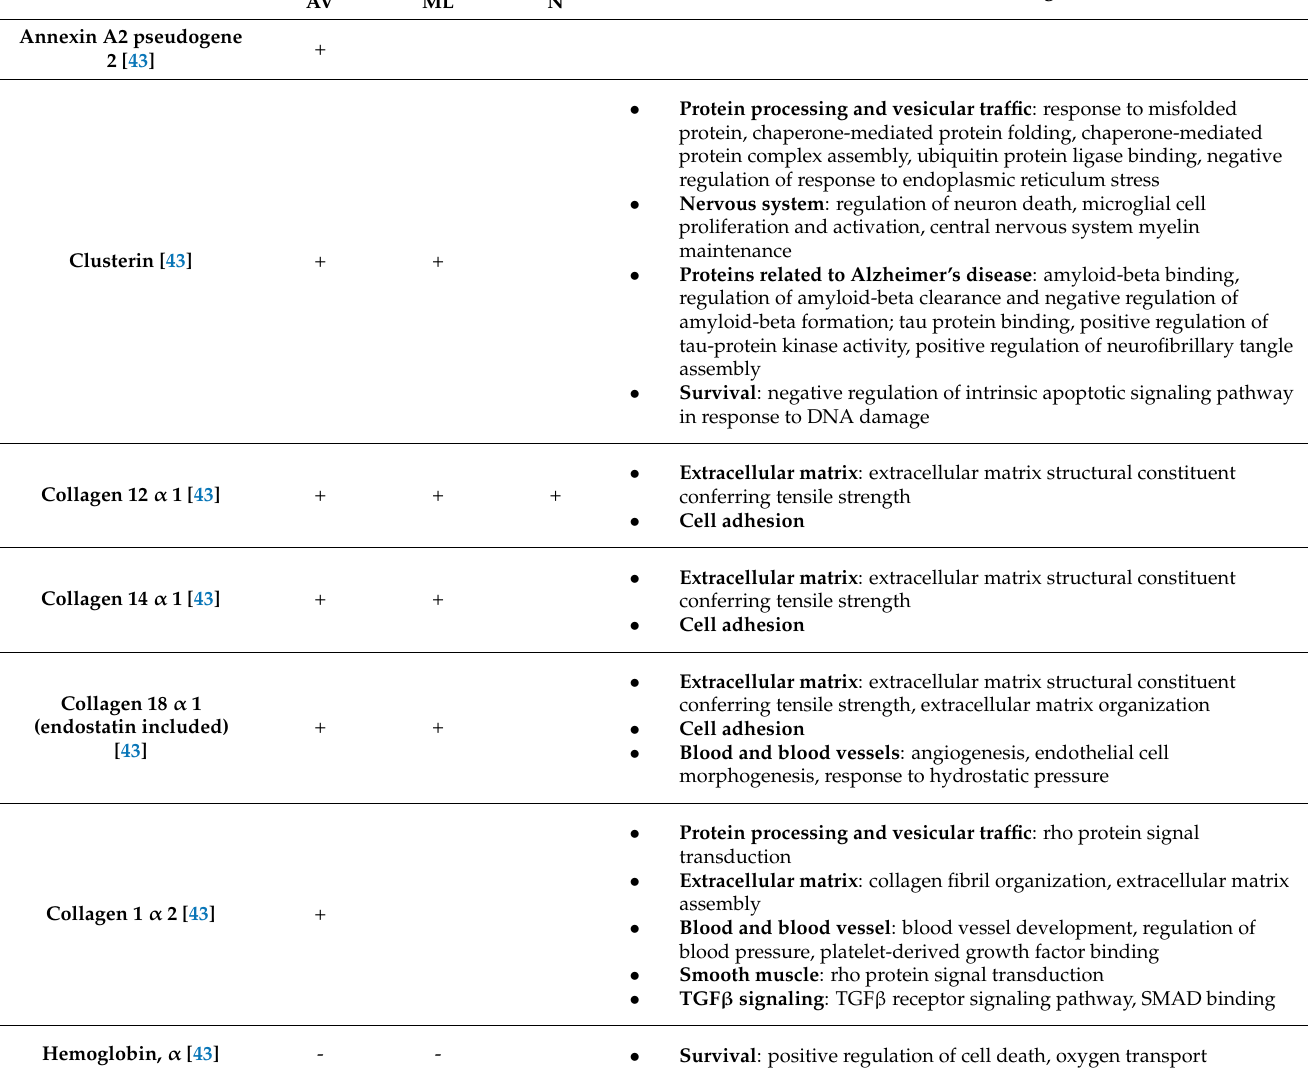
Table 1. Proteomic analysis of human brain vessels. Proteins whose levels were different between patients with CADASIL and controls in the study by Arboleda-Velasquez et al. [43], Monet-Lepr ê tre et al. [44], and Nagatoshi et al. [47]. Protein